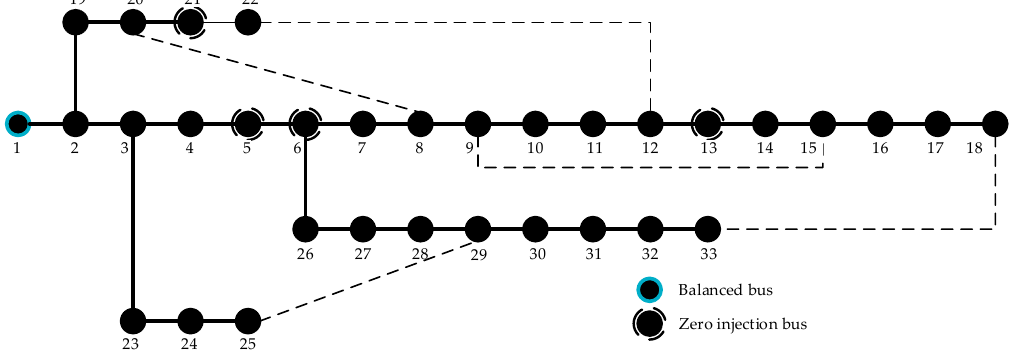
Figure 8. IEEE 33 bus system.